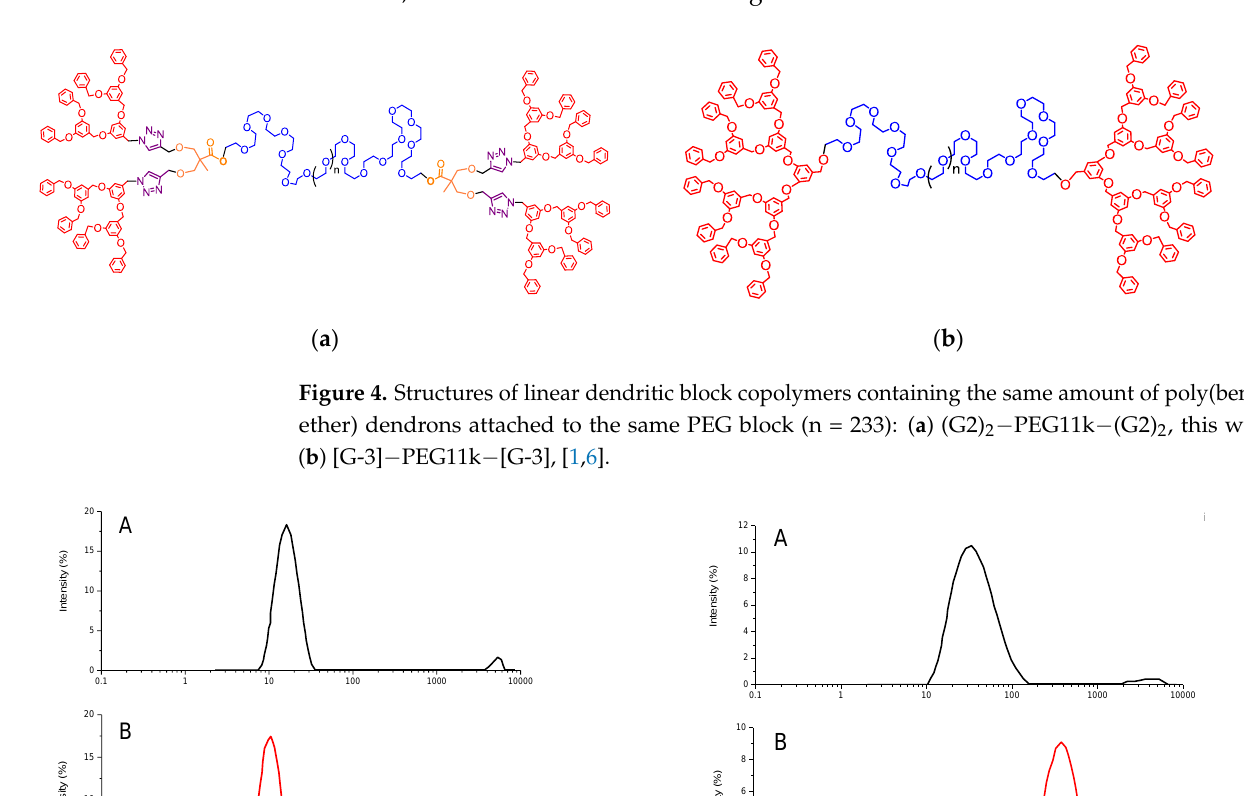
nm for the PEG5k copolymers and 37 nm vs 44 nm for the PEG 11k copolymers, Figure 5A [6]. In analogy with previously synthesized [G-3]-PEG5k-[G-3] ([1]), the newly formed (G2) 2 -PEG5k-(G2) 2 did not dissolve in water forming transparent physical networks, which were not further investigated.